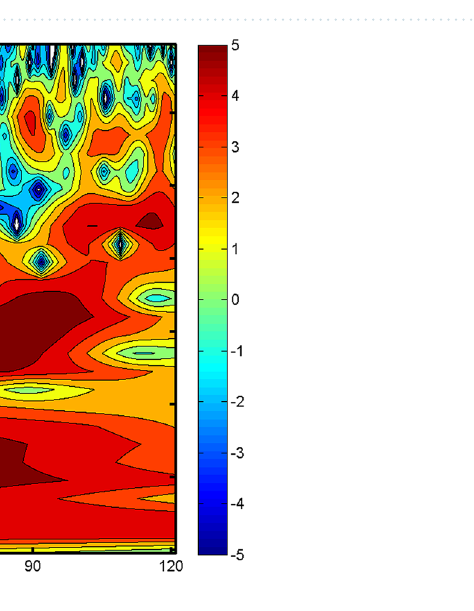
Figure 5. Wavelet coefficient of the vertical velocity for the roll leg as in Fig. 4 during the flight in Typhoon